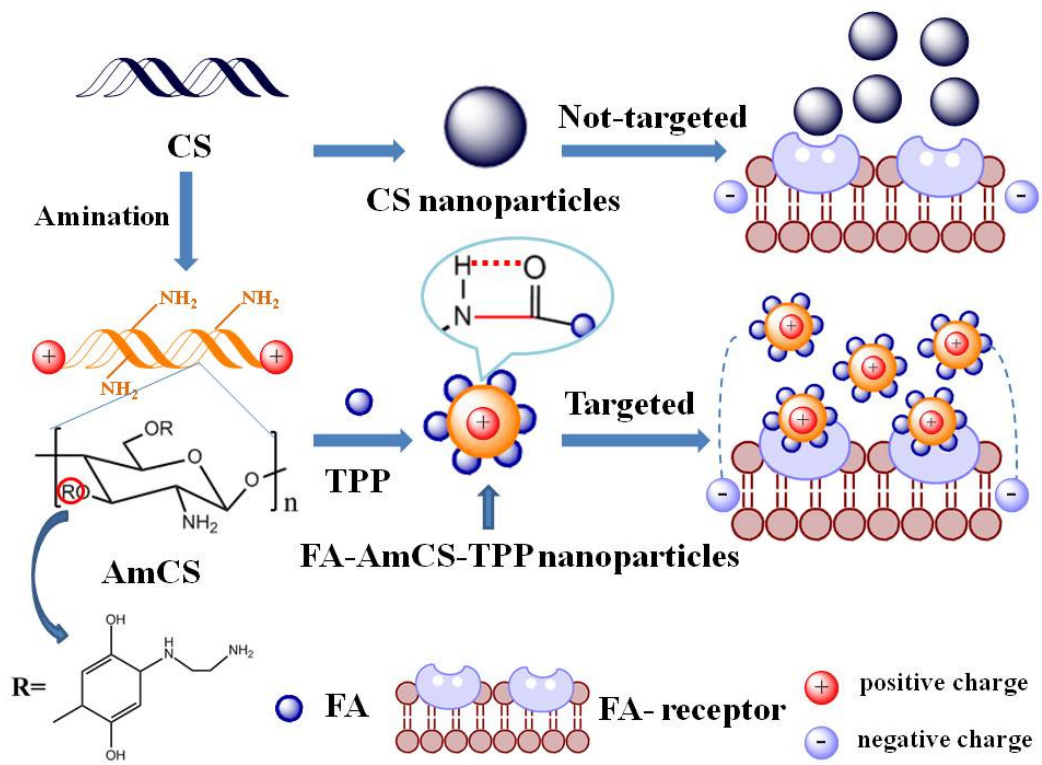
Figure 1. Scheme of the preparation and action mechanism of FA-AmCS-TPP nanoparticles.